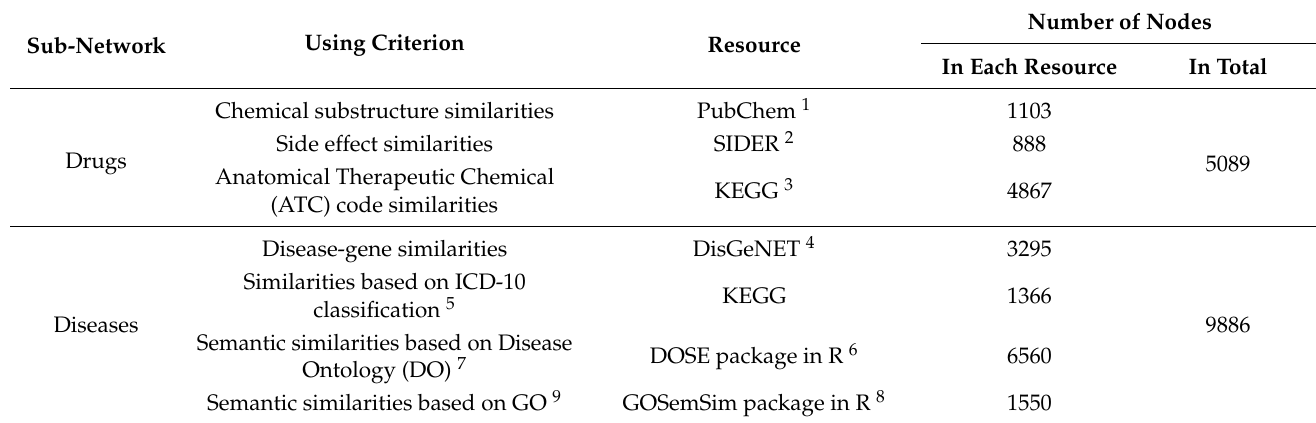
Table 1. Resources of data related to each sub-network and the number of nodes in each one.